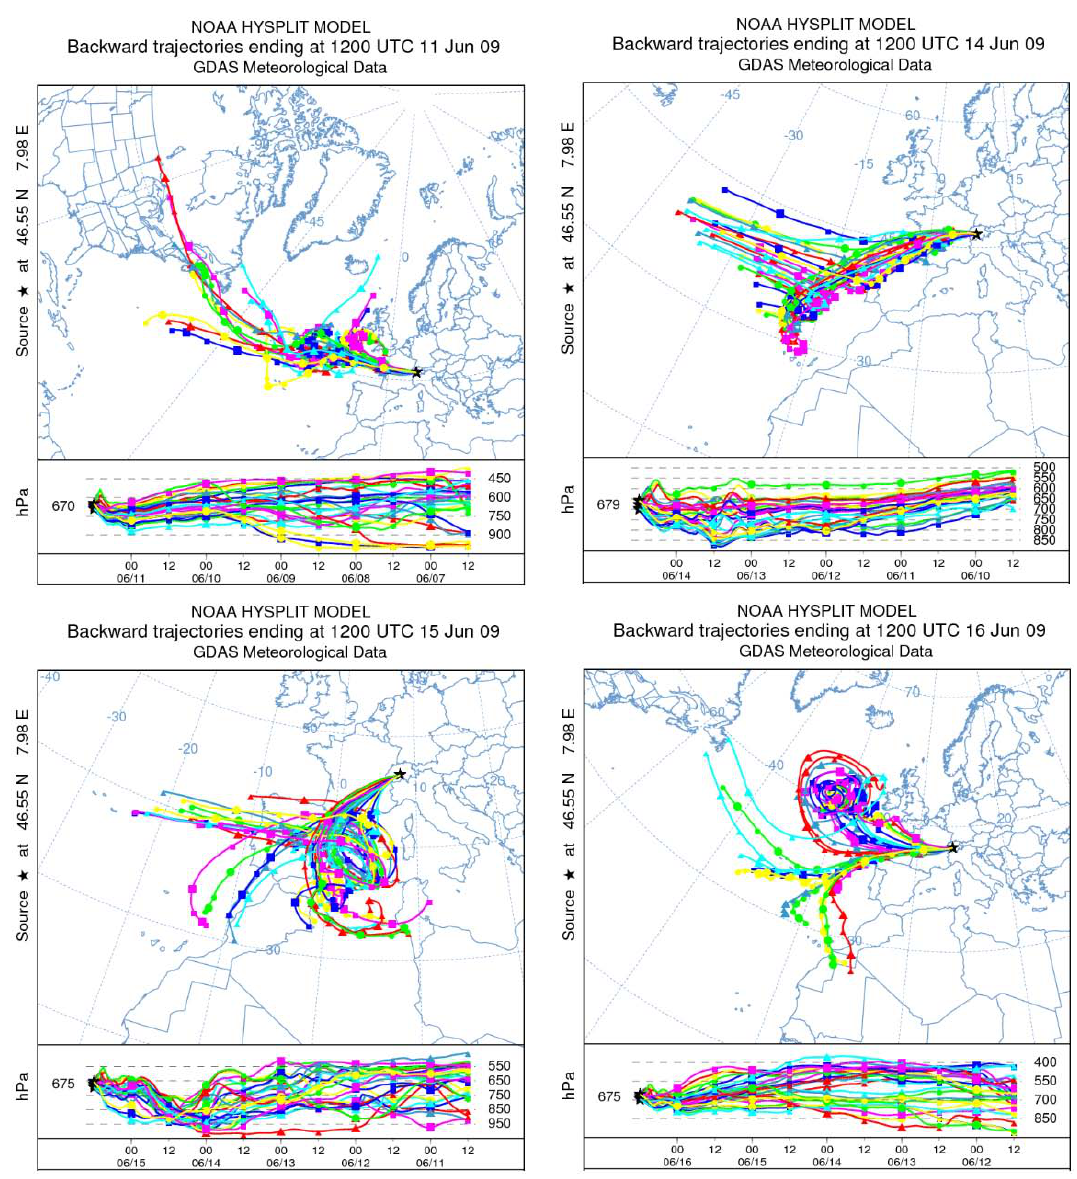
Fig. 10. Four days backtrajectories on 11, 14, 15, and 16 June 2009 at Jungfraujoch at 12:00p.m.